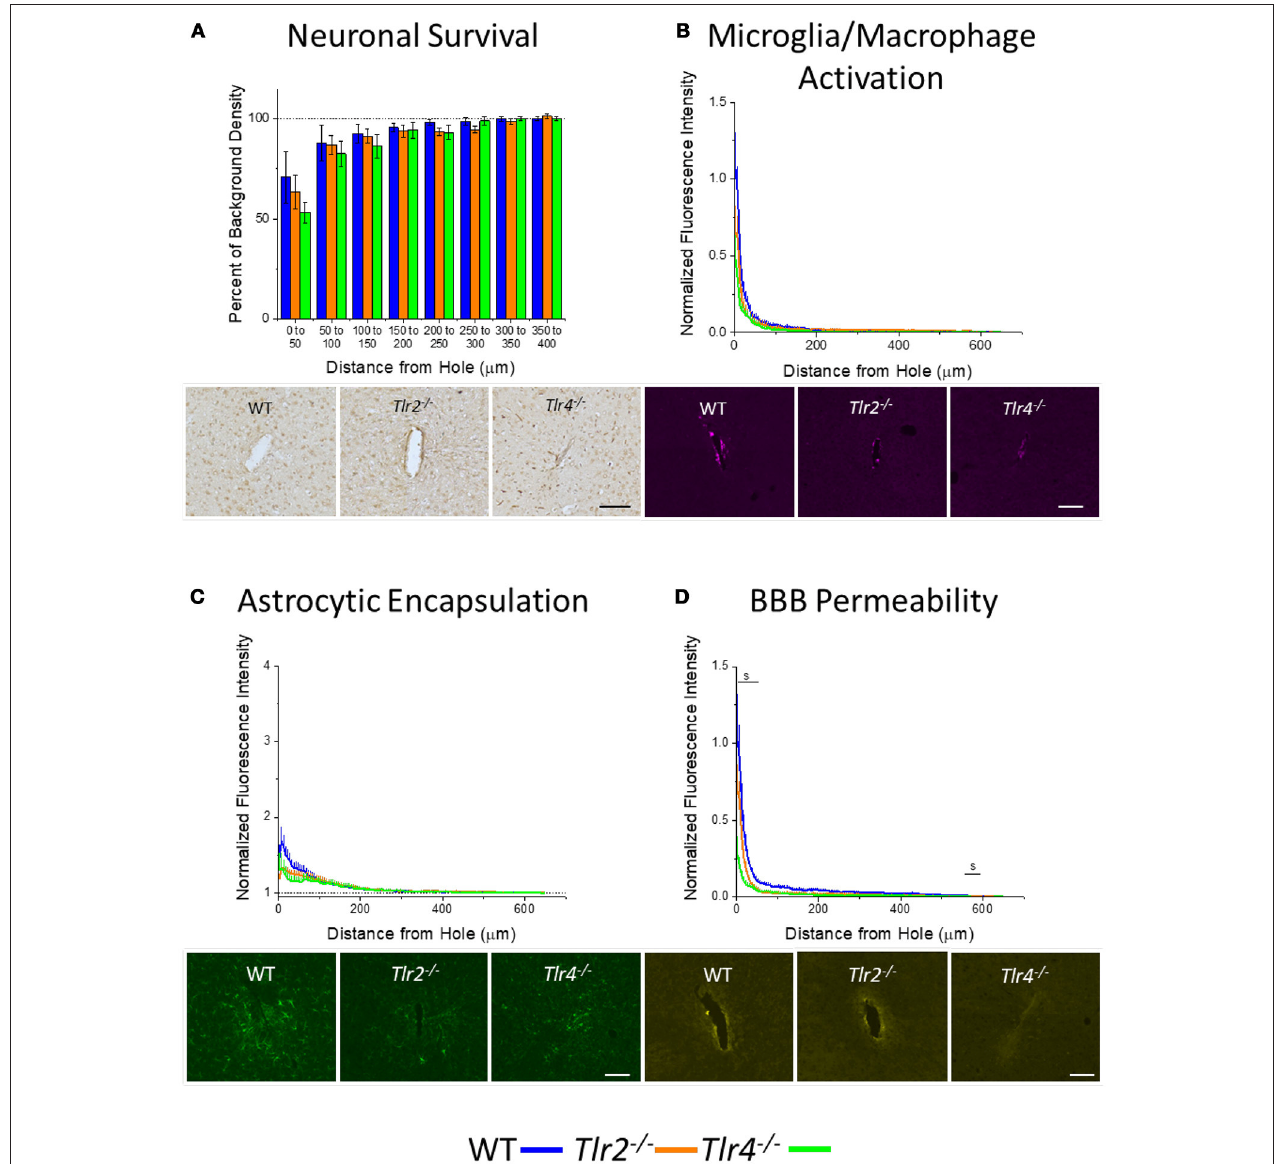
FIGURE 2 | Acute immunohistochemical evaluation of Tlr2 − / − , Tlr4 − / − , and wildtype mice two weeks after probe implantation. (A) Neuronal survival in cortical tissue around implanted probes presented as percent of background density with respect to distance from probe hole ( µ m). No significant differences were observed between either of the knockout conditions and wildtype mice. Tlr2 − / − : N = 7; Tlr4 − / − : N = 5; WT: N = 5. (B) Microglia and macrophage activation in cortical tissue around implanted probes presented as normalized fluorescence intensity with respect to distance from probe hole ( µ m). Normalized fluorescence intensity indicates expression of CD68. No significant differences were observed between either of the knockout conditions and wildtype mice. Tlr2 − / − : N = 8; Tlr4 − / − : N = 4; WT: N = 6. (C) Astrocyte encapsulation in cortical tissue around implanted probes presented as normalized fluorescence intensity with respect to distance from probe hole ( µ m). Normalized fluorescence intensity indicates expression of GFAP. No significant differences were observed between either of the knockout conditions and wildtype mice. Tlr2 − / − : N = 8; Tlr4 − / − : N = 4; WT: N = 6. (D) Blood-brain barrier permeability presented as normalized fluorescence intensity with respect to distance from probe hole ( µ m). Normalized fluorescence intensity indicates expression of IgG. Tlr4 − / − mice exhibited significantly less IgG expression within distances of 0–50 and 550–600 µ m from the probe hole, indicating reduced blood-brain barrier permeability, $ p < 0.05. Tlr2 − / − : N = 5; Tlr4 − / − : N = 4; WT: N = 6. Orange = Tlr2 − / − , Green = Tlr4 − / − , and Blue = WT. Scale bars are provided for each set of images, scale = 100 µ m.